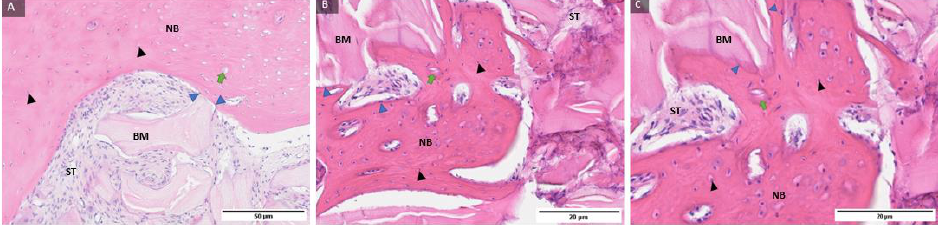
Figure 1. Examples of preparations of the control group ( A – C ) with labeled newly formed bone (NB), residual biomaterial (BM), soft tissue (ST), osteoblasts (blue filled triangle), osteocytes (black filled triangle), and Howship lacunae in the bone bed with a blood vessel (green arrow). Magnification: 100, 200, 400 ×